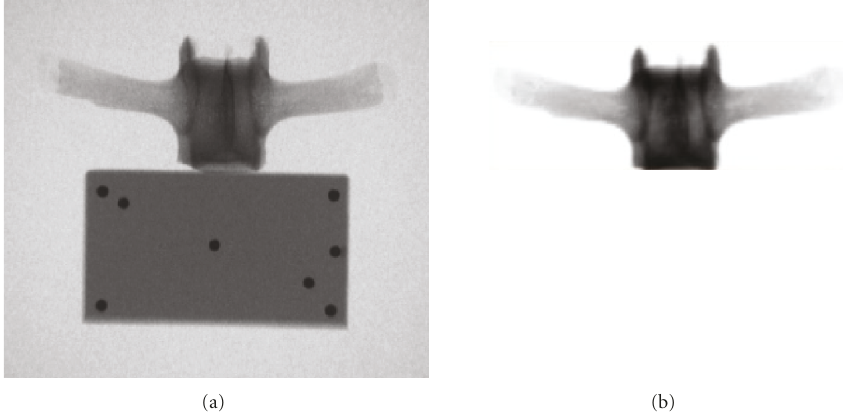
Figure 6: A real antero-postetior DVF of the calibration object (a): the radio-transparent frame attached below the vertebra and the inserted metallic markers are also visible; an equally oriented DRR (b) obtained by the CT 3D vertebra model is shown for